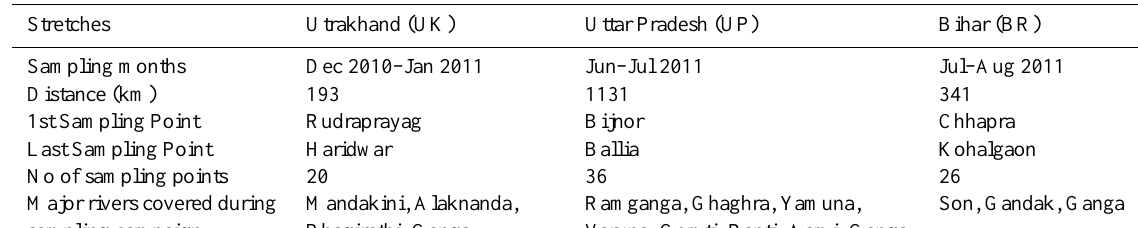
Table 1. Various river stretches and the major rivers covered during the sampling campaigns.